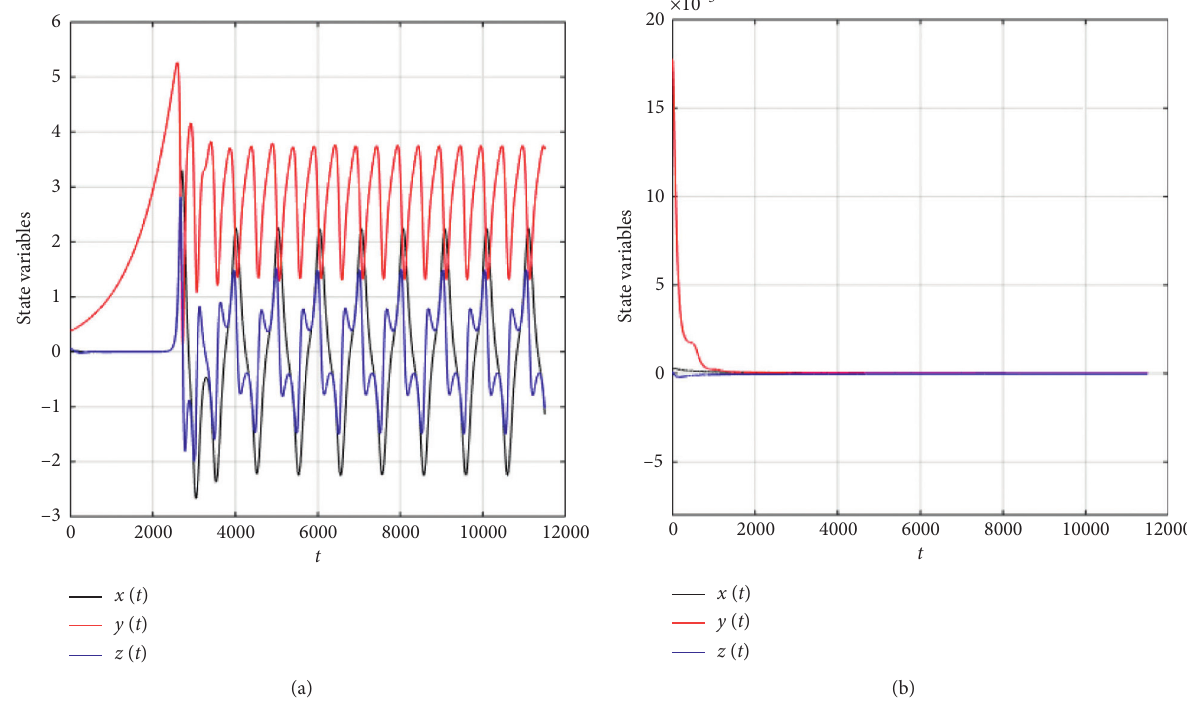
Figure 8: Trajectories of chaotic FOS delay system (40) with a � 0 . 4 , b � 0 . 175 , c � 0 . 4 , and α � 0 . 99 (a) are not stabilized to (0,0,0) when no control is applied and (b) converge to the origin steady state using the FCGs k